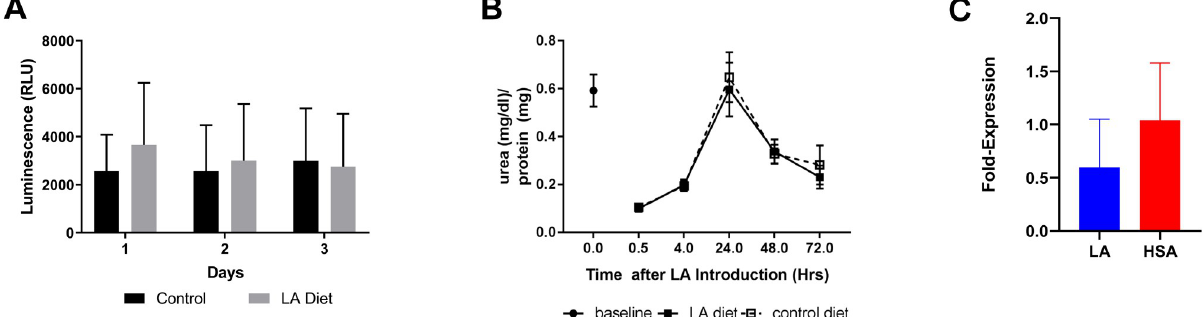
Fig 4. Hepatocyte viability is maintained over study period. (A)There was no significant difference in cell viability between LA and control groups at any time based on luminescence measurements from the ATP quantification assay (n = 3/group). (B) Hepatic functionality, as measured by urea, was not impacted by LA feeding over 3 days of culture. Maximum urea levels were detected 24 hours post-feeding in both LA and HSA-control groups, indicating that the constructs were capable of secreting urea up to baseline levels following LA or HSA exposure. (C) The expression levels of CYP1A1, a member of the cytochrome P450 family, were not significantly impacted by feeding with LA or HSA when compared to pre-feeding